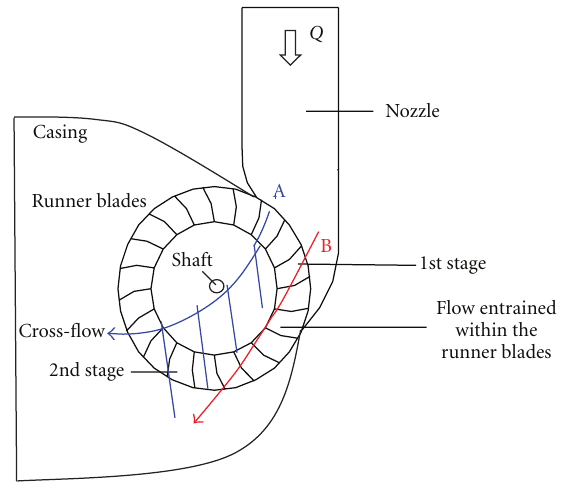
Figure 1: Flow distribution within the runner of a cross-flow